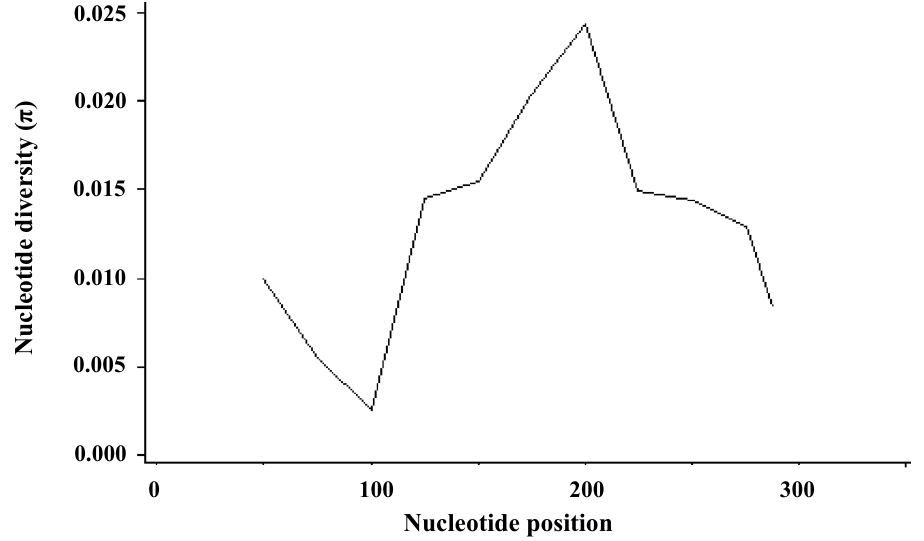
Figure 5. Genetic diversity of different nucleotide position in gltA gene of B . grahamii . Genetic diversity was analyzed using DNASP 6.12.03 (http:// www. ub. edu/ dnasp) with a sliding window interval of 25 bp.